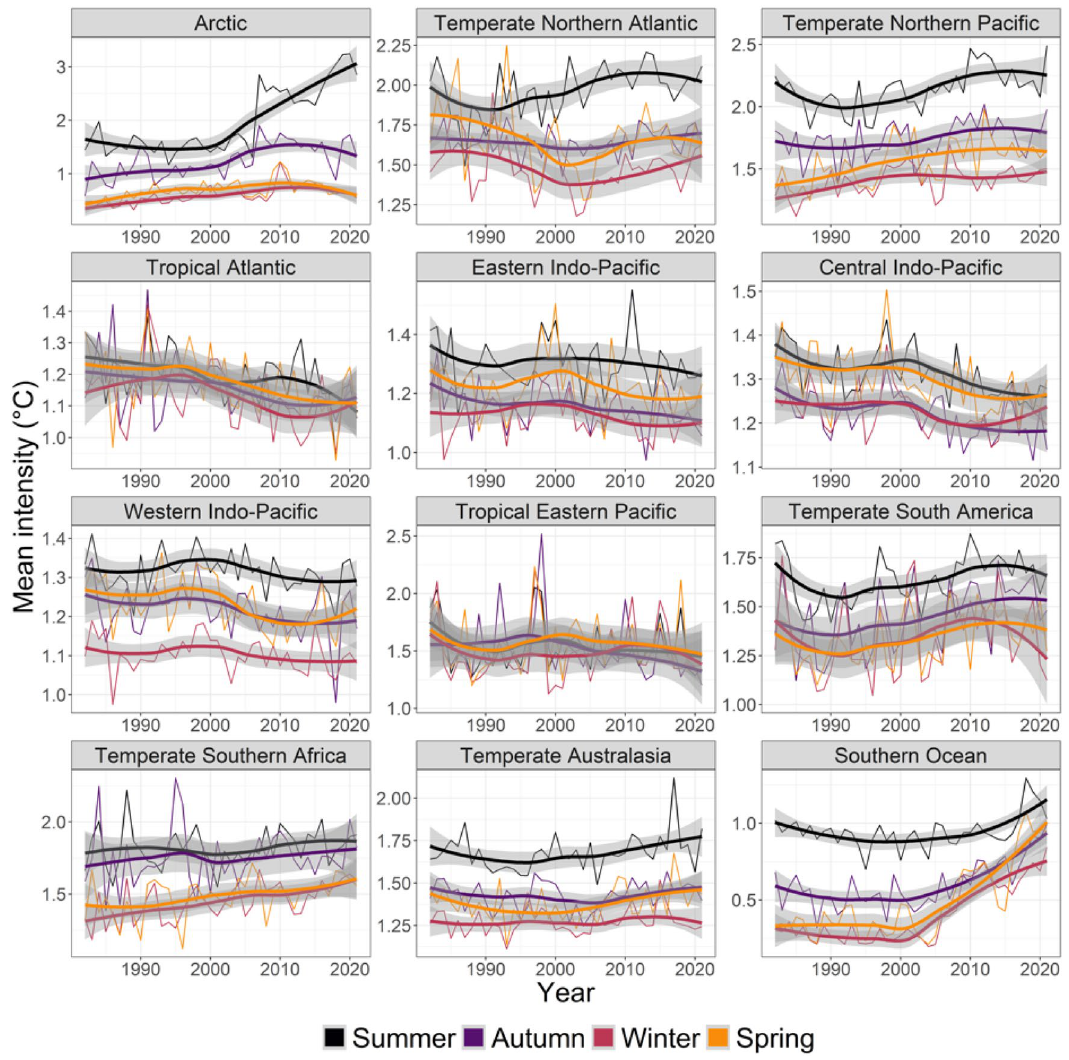
Figure 5. Seasonal trends from 1982 to 2021 in the yearly- and pixel-averaged mean intensity (°C) of marine heatwaves per coastal realm and season. See Fig. 2 caption for more details and Table S4 for specific trendlines, p values and break point